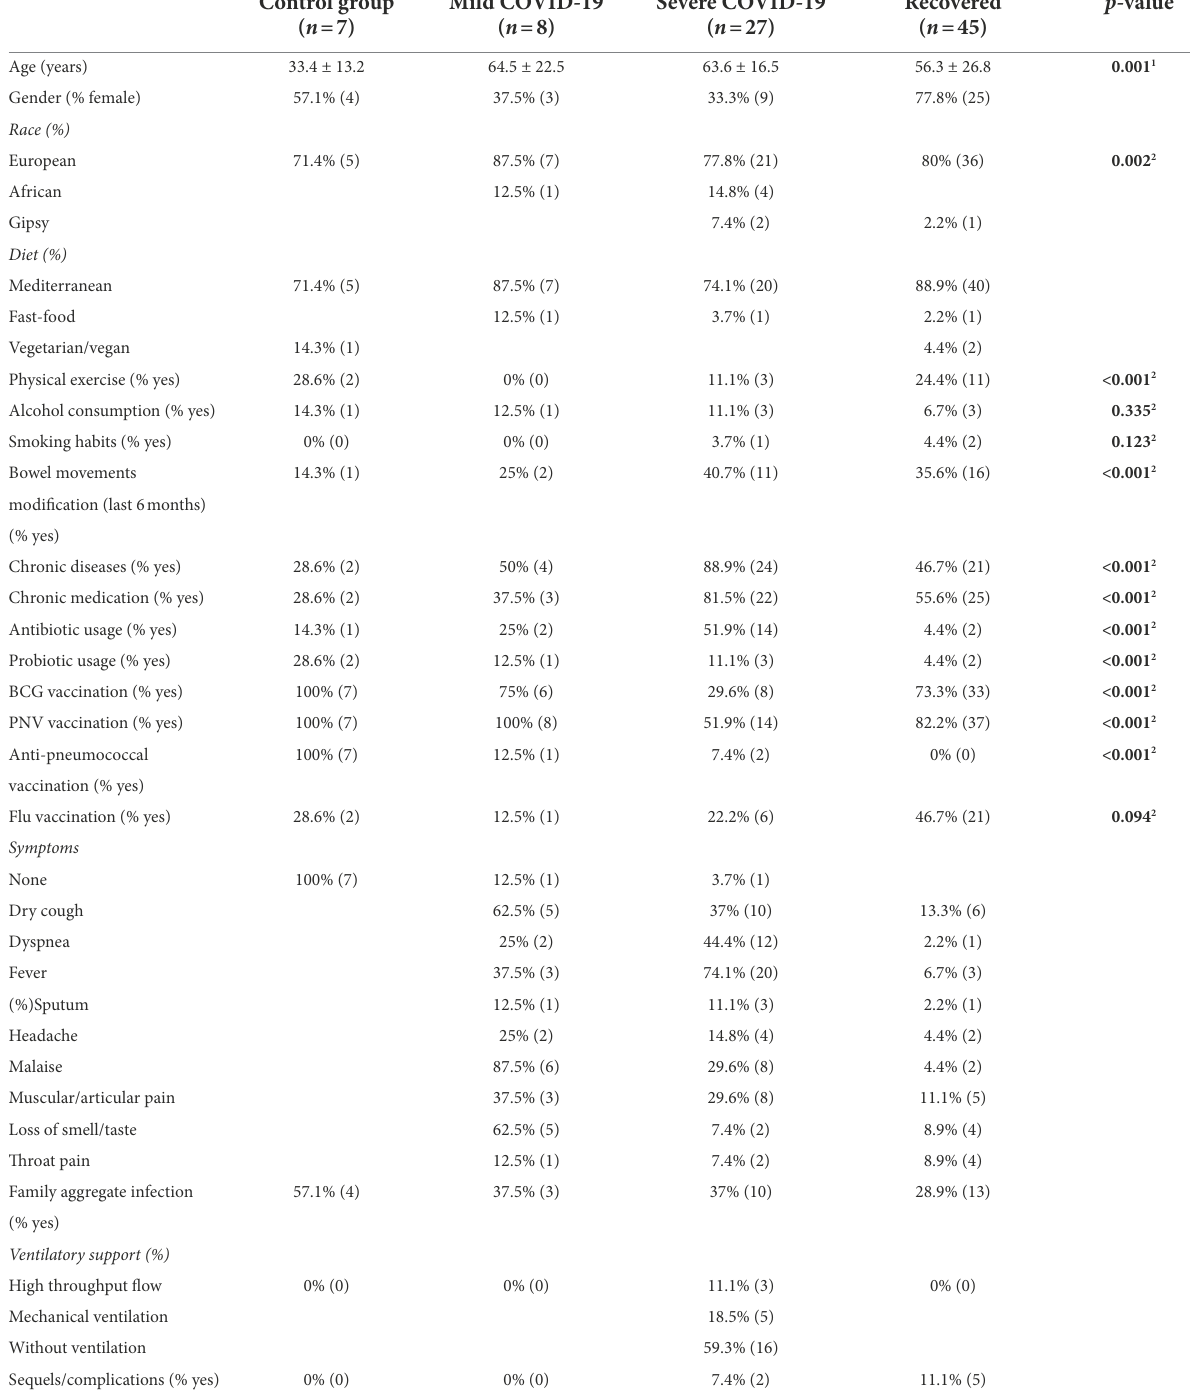
TABLE 1 Demographic and clinical characteristics of the study population. Statistical analysis was performed with ANOVA/Kruskal–Wallis test or Chi-square/Fischer